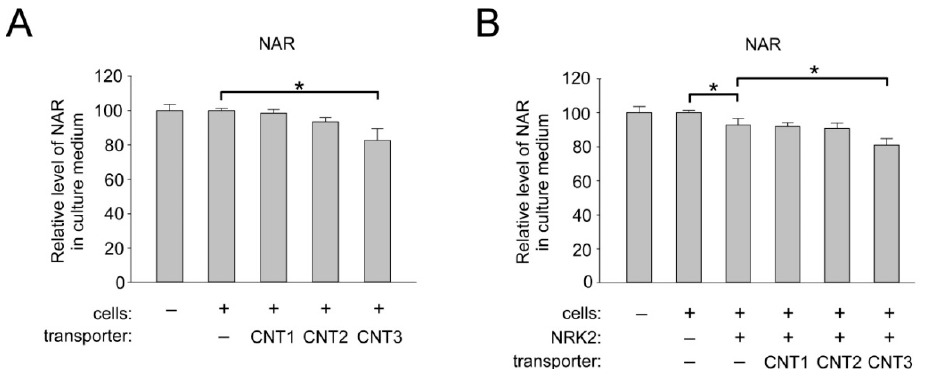
Figure 5. Overexpression of CNT3 moderately stimulates NAR uptake into HEK293 cells. HEK293 cells cultivated in DMEM were transiently transfected with vectors encoding FLAG-tagged CNT1, -2, or -3 or control (empty) vector ( A ). Cells were also cotransfected with a vector encoding FLAG-tagged NRK2 as indicated ( B ). Twenty-four hours after transfection, cells were treated with nicotinic acid riboside NAR (50 µ M). Twenty-four hours after treatment, culture medium was analyzed by NMR spectroscopy. Relative levels of NAR in culture medium are presented. The amount of NAR in control culture media incubated without cells was taken as 100. Data are presented as mean ± S.D ( n = 3). Statistical analysis of differences between the groups was carried out by one-way ANOVA with post hoc comparisons using Tukey test. * indicates statistical significance at p <